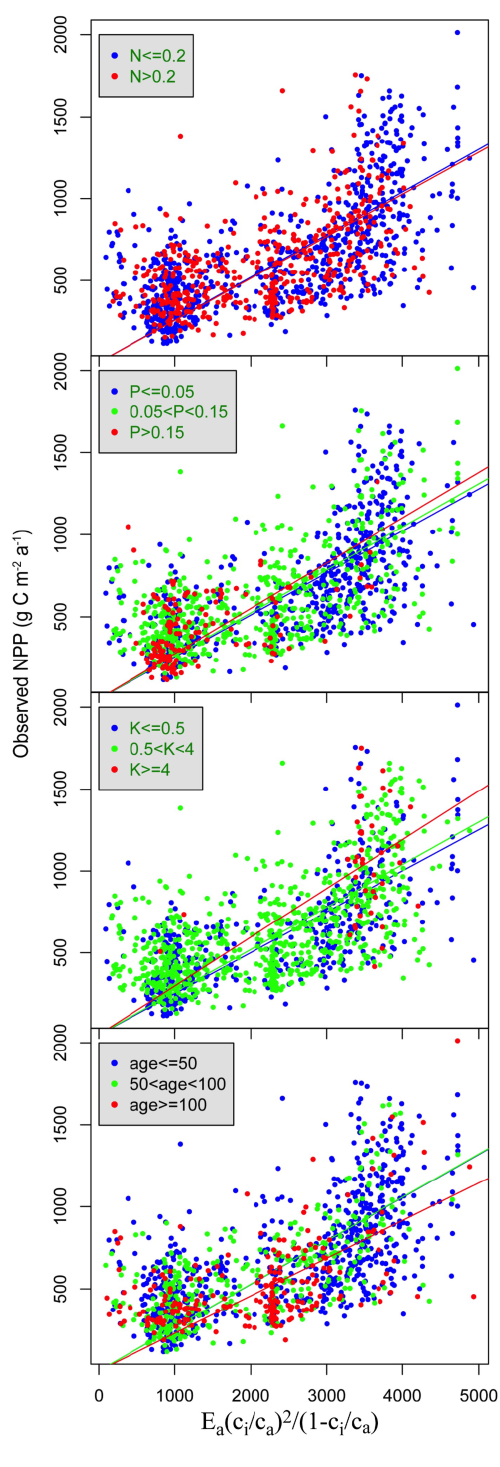
Fig. 3. Relationships between forest NPP and Level 1 WUE model predictors for different levels of soil nitrogen (N), phosphorus (P), potassium (K) concentrations, and stand ages